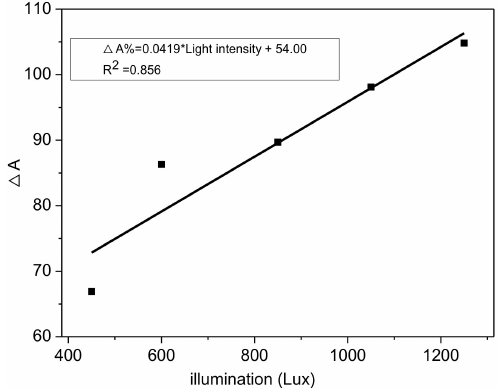
Figure 4. Change in amplitude against light intensity. Common conditions: [H 2 SO 4 ] 0 = 1.05 M; [Acetone] 0 = 0.65 M; [Glucose] 0 = 0.06 M; [Sodium bromate] 0 = 0.08 M; [CuL](ClO 4 ) 2 ] 0 = 0.05 M; ultraviolet light applied at 245 nm.